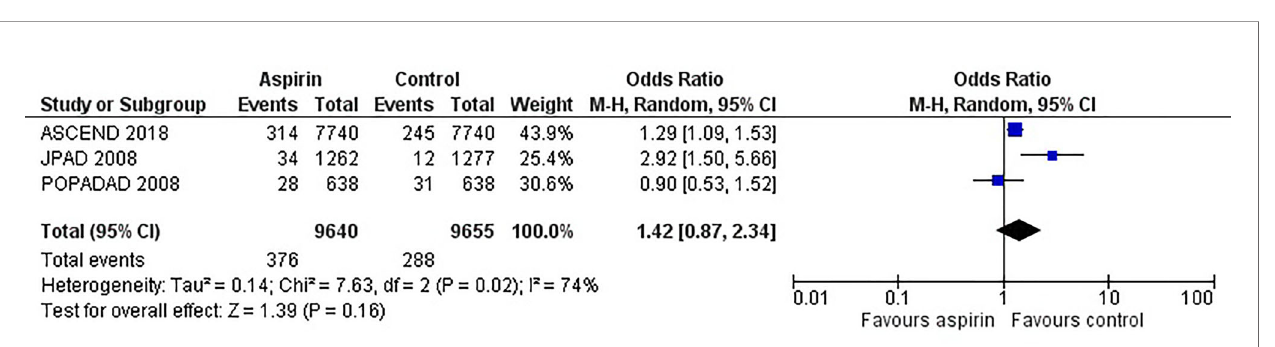
FIGURE 4 | Forest plot for the outcome of bleeding events using a random-effects model. Odds ratios and 95% con fi dence intervals are shown. Control: placebo or no